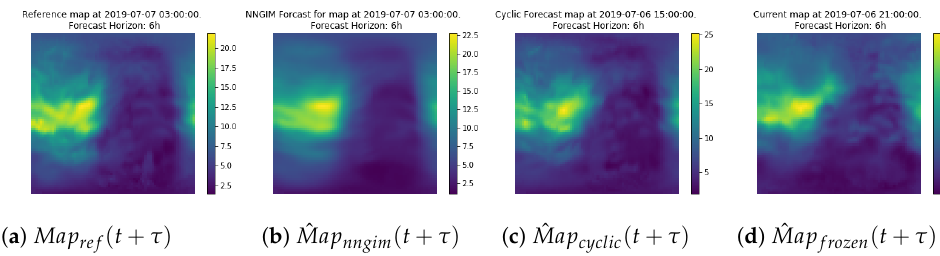
Figure 5. Selected sequence of predictions for the map at 2018-07-14 20:45:00 UT. The upper row shows the reference to 16 h, 20 h, 24, 48 h, the second row shows the prediction result. Note that the color bars are not at the same scale. The maps range in latitude from 90 degrees north to 90 degrees south, and in longitude from 180 degrees west to 180 degrees east. Color bars are in TEC units.